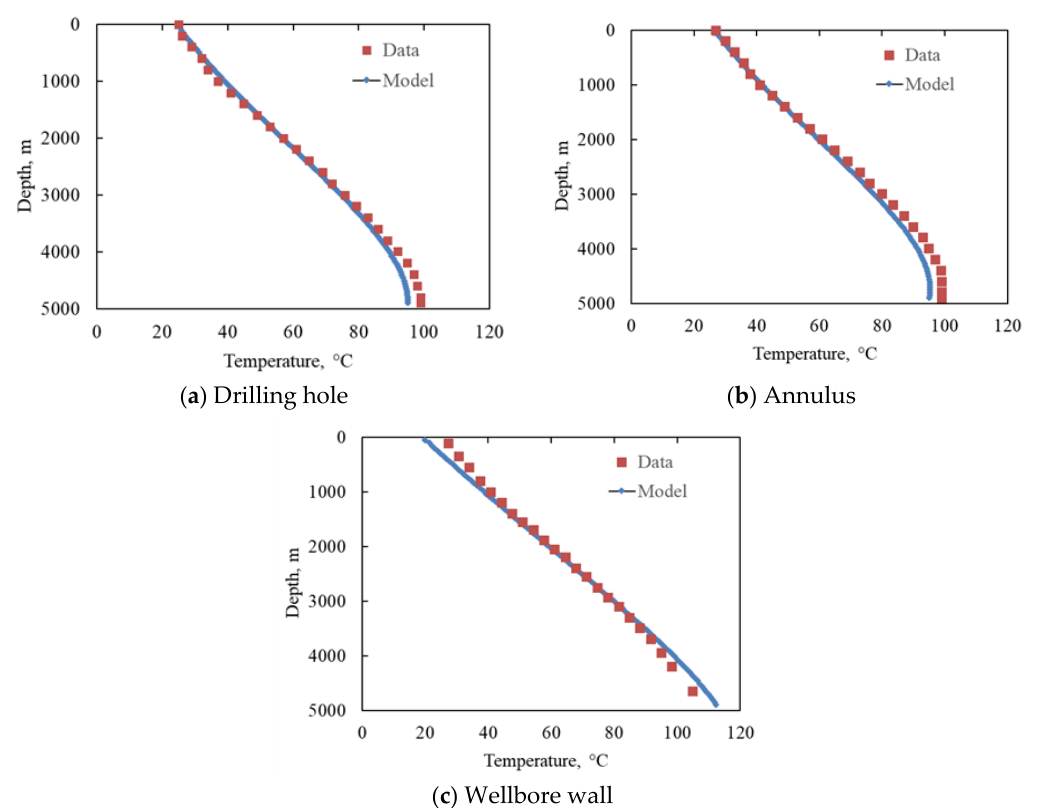
Figure 4. Comparison of calculated temperature with reference data.